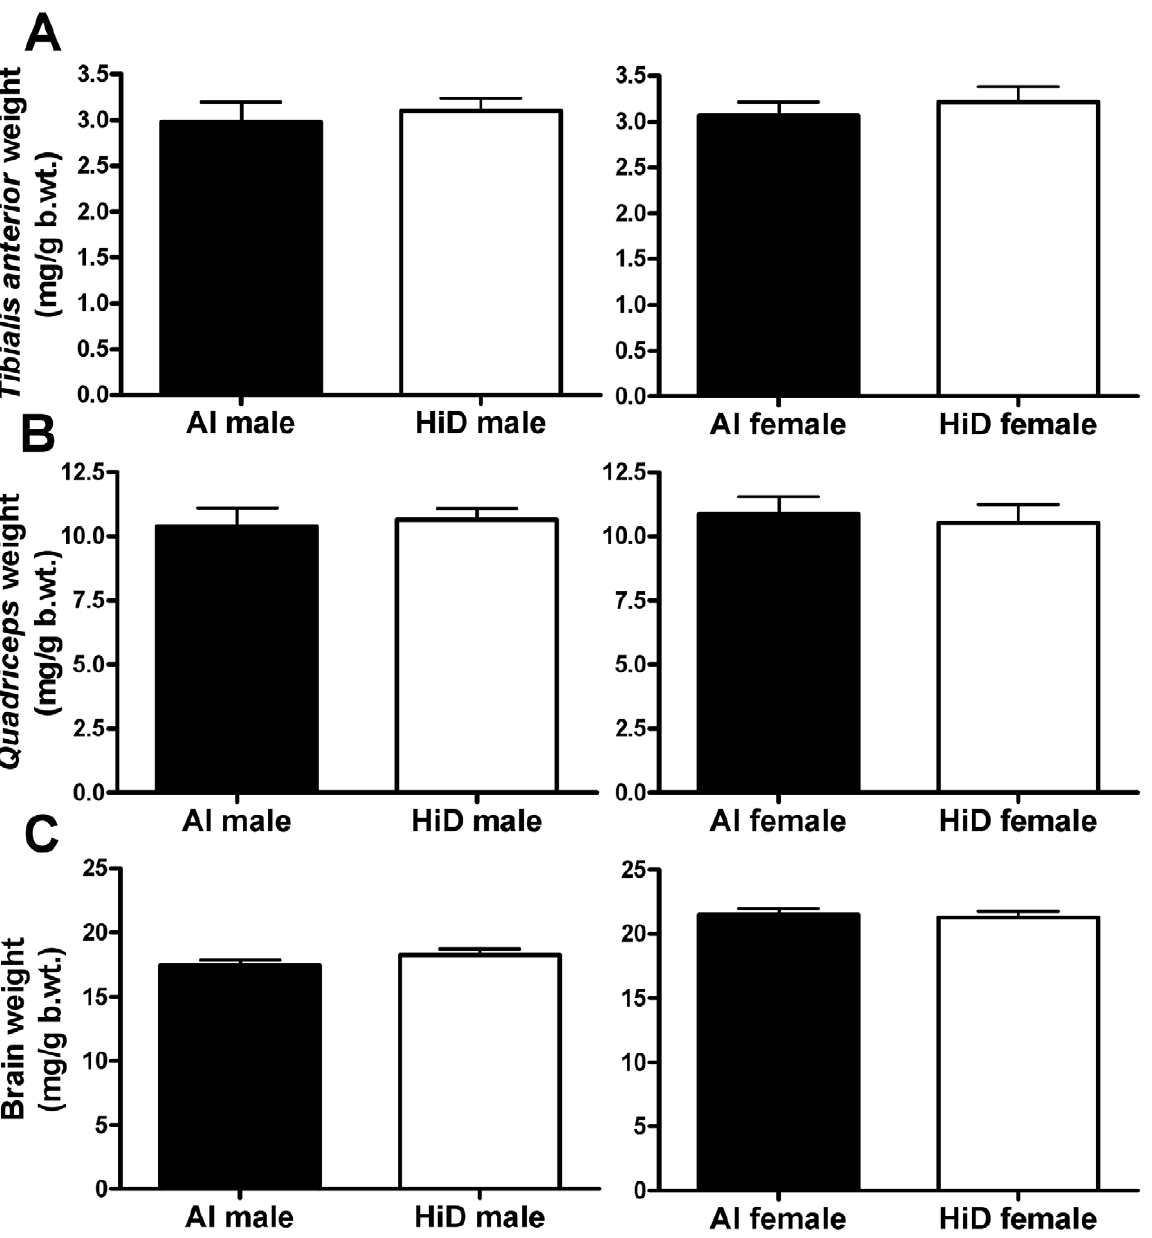
N , 11 females) and 18